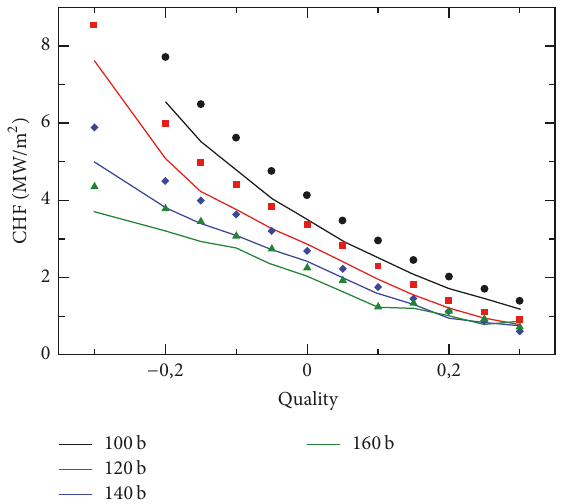
Figure 49: Tube diameter of 10mm. Experimental values are represented by points.